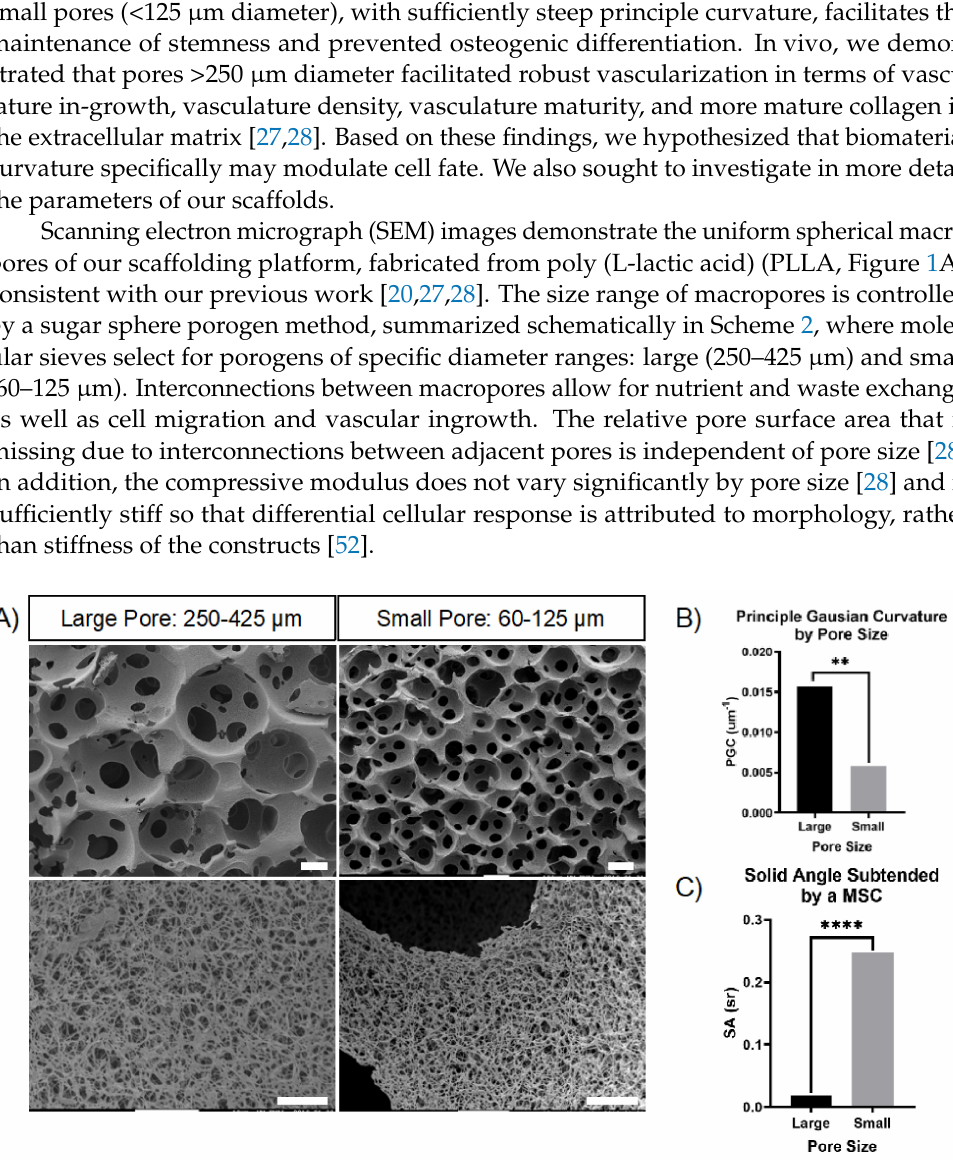
Figure 1. Nanofibrous, macroporous tissue engineering scaffolds visualized by scanning electron microscopy (SEM) (( A ), scale: top = 100 µ m; bottom = 10 µ m). Image analysis of SEM images is used to calculate average principle curvature ( B ) and the average area subtended by a mesenchymal stem cell (MSC, ( C )). ** = p < 0.01; **** = p <